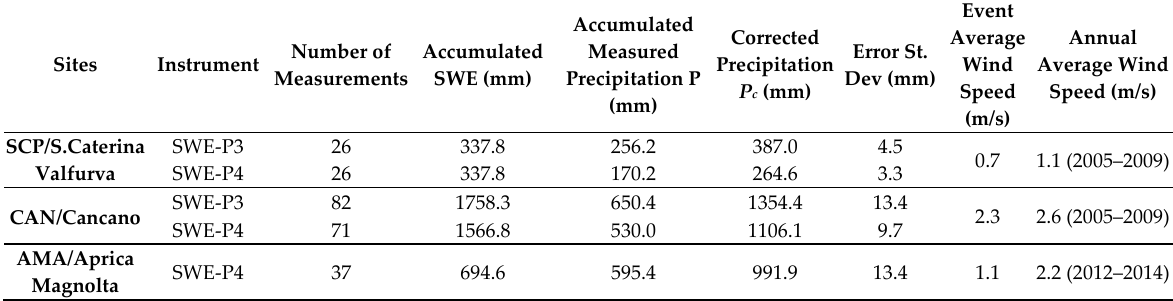
Table 5. Data used for the verification of the correction procedure based on both temperature and wind speed data. The coefficient C s,w is calibrated by minimising the RMSE of the corrected precipitation P c vs. the ‘true’ value of fresh fallen snow SWE. Uncorrected rain gauge precipitation measurements are indicated by